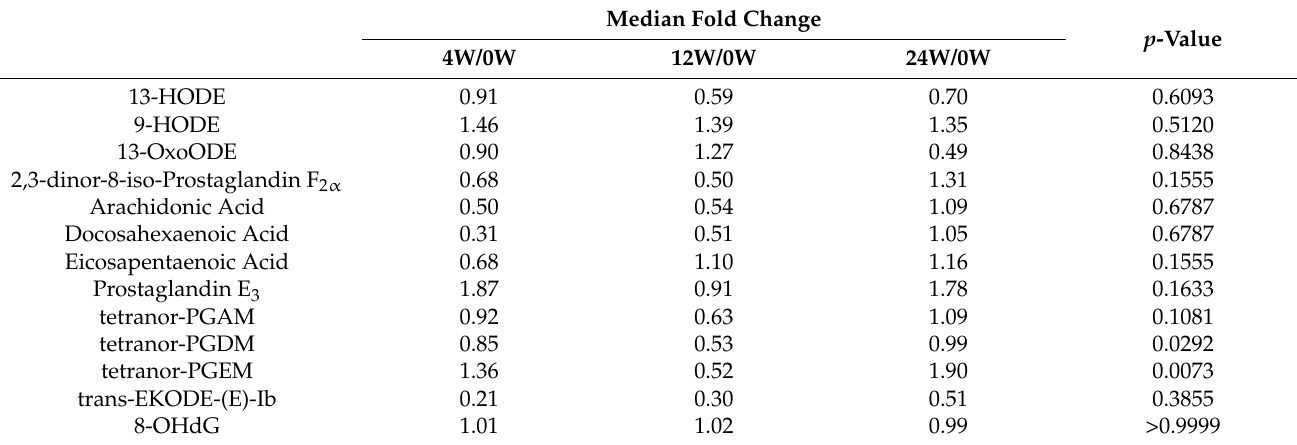
Table 2. Median fold changes in metabolite levels after tranilast